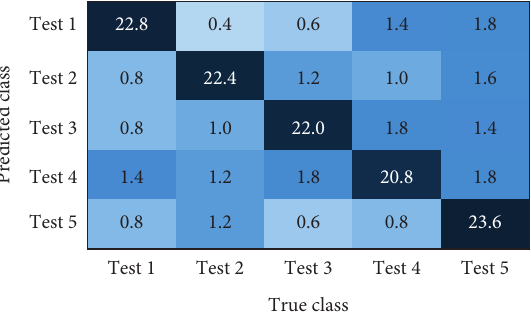
Figure 18: Confusion matrix of the test